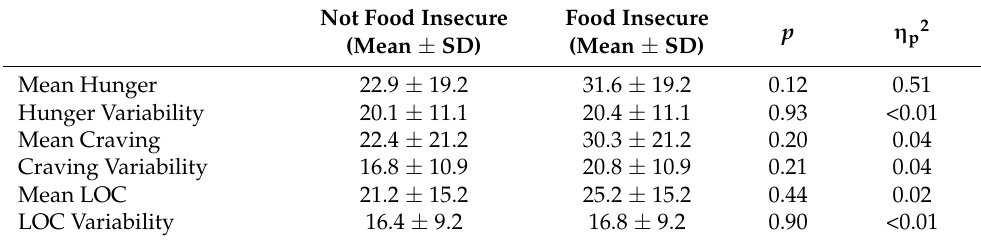
Table 3. Ecological momentary assessment of hunger, craving, and LOC eating.